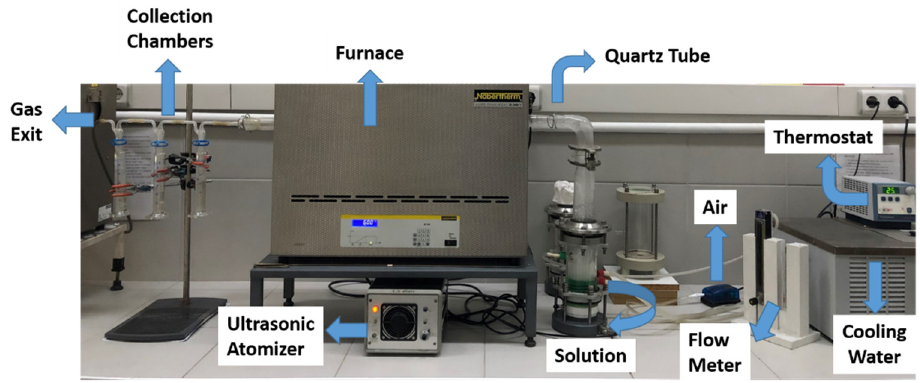
Figure 1. General view of the experimental setup.